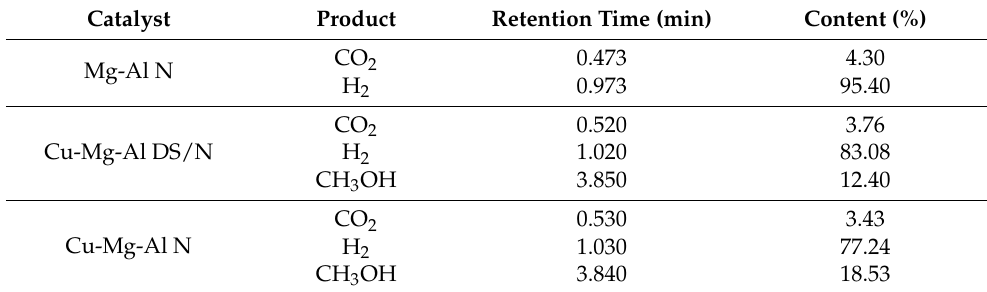
Table 5. Product chromatographic results for different